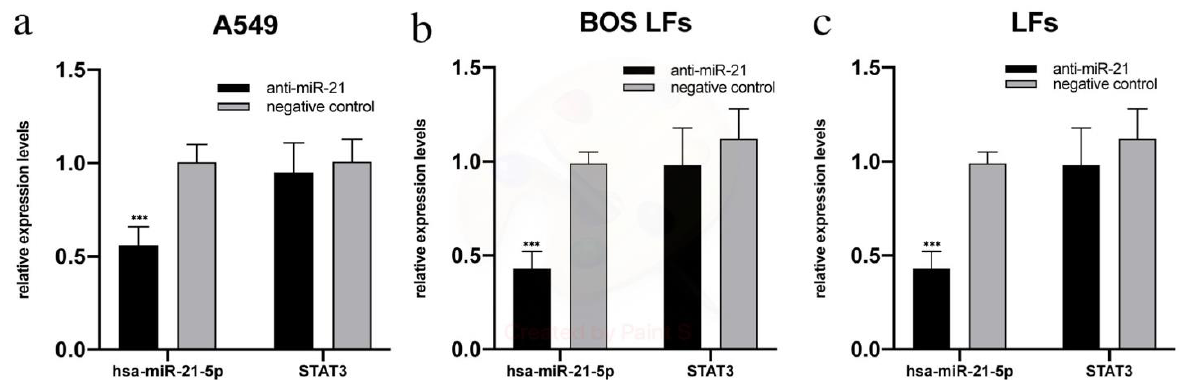
Figure 5. qRT-PCR analysis of miR-21-5p/STAT3 mRNA expression levels: ( a ) in A549, mean ± standard deviations of replicates; ( b ) in Lung fibroblasts (LFs) derived from BOS patients, mean ± standard deviations of all cell lines; ( c ) in LFs derived from patients without chronic lung allograft dysfunction (CLAD), mean ± standard deviations of replicates. *** p < 0.001.